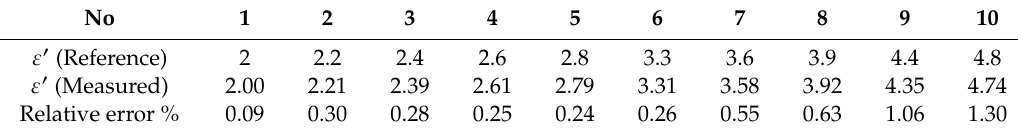
Figure 14. The distribution of the measured points in the fitting curve. Table 2. Comparison of the measurement results.